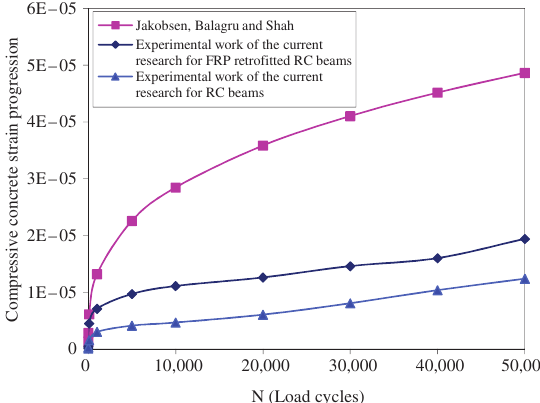
Figure 6: Progression of maximum compressive strain of concrete versus load cycle during fatigue